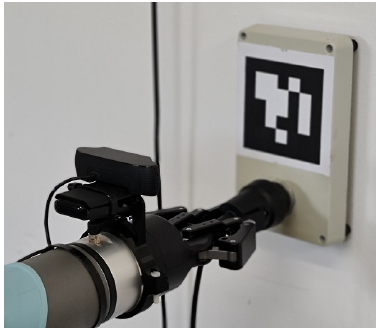
Figure 10. Plugging in the